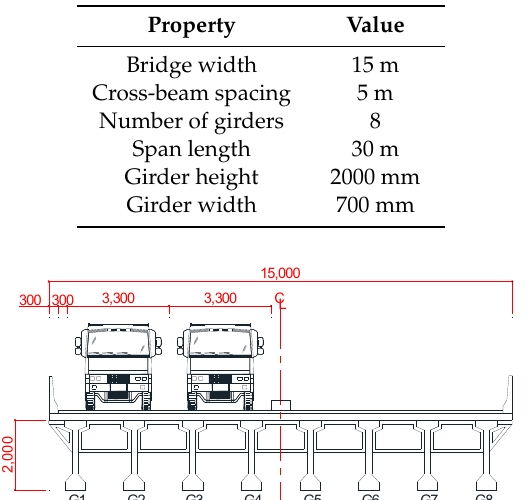
Table 1. Section properties of the pre-stressed concrete-I (PSC-I) bridge.